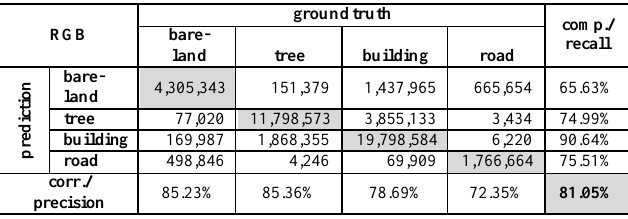
Table 2. Confusion matrix of segmentation result using RGB composition.